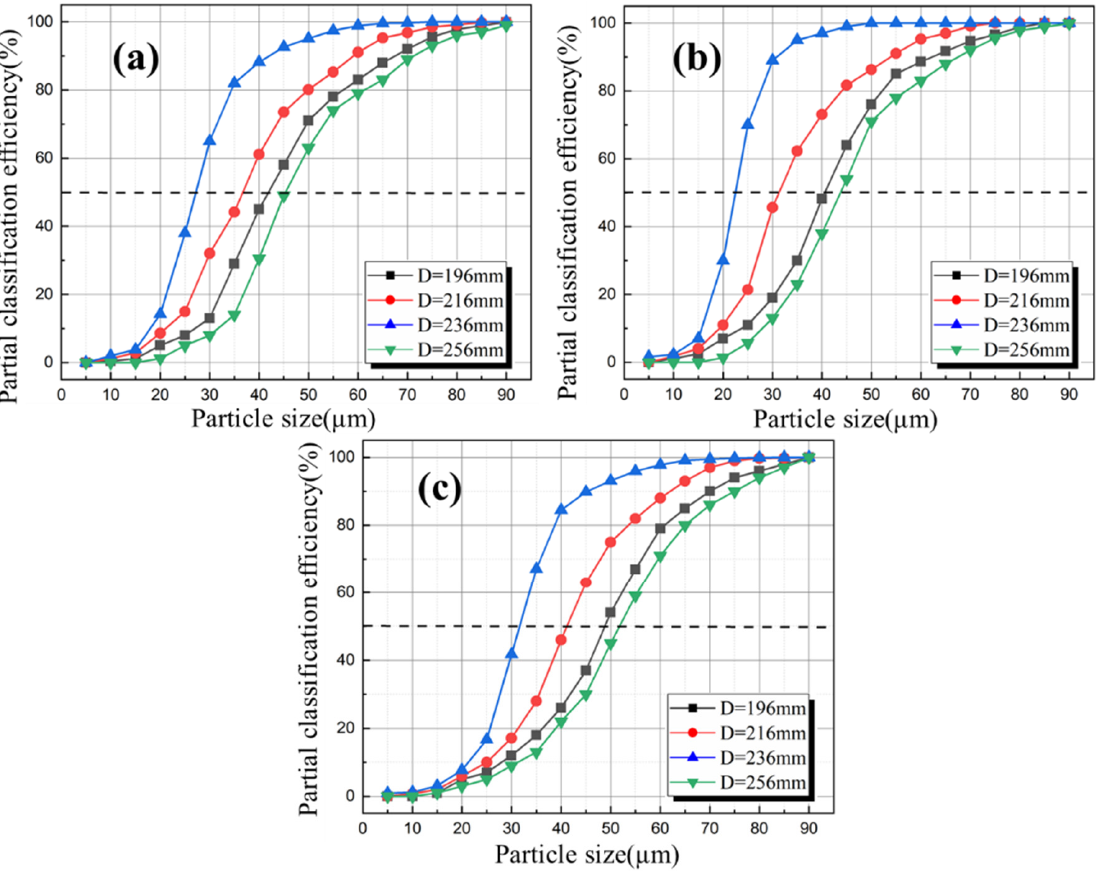
Figure 17. Tromp curves of classifiers with different guide cone diameters: ( a ) 14 m/s ‐ 500 rpm, ( b ) 14 m/s ‐ 600 rpm, ( c ) 16 m/s ‐ 500 rpm.